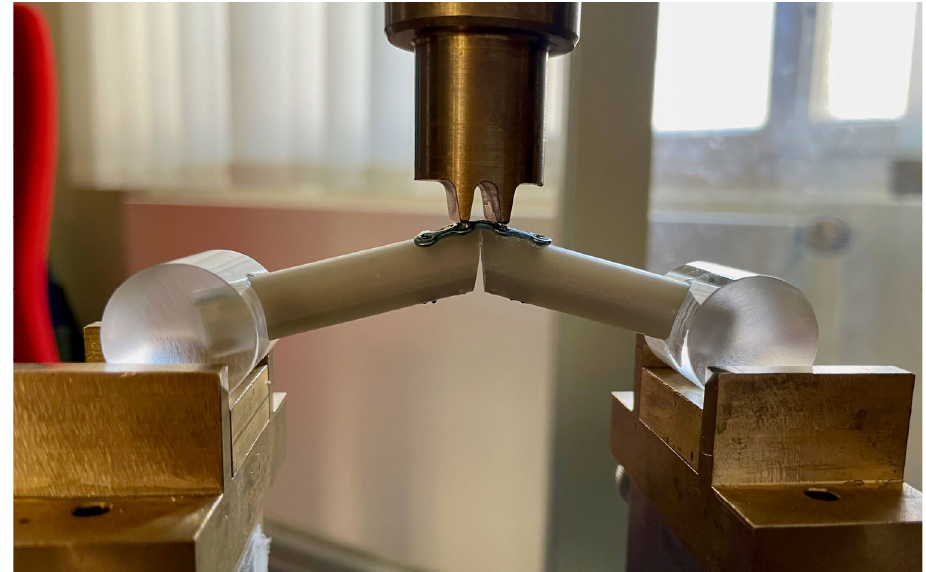
Figure 1. Four ‐ point bending of a composite cylinder arthrodesis in 40° fused with a locking